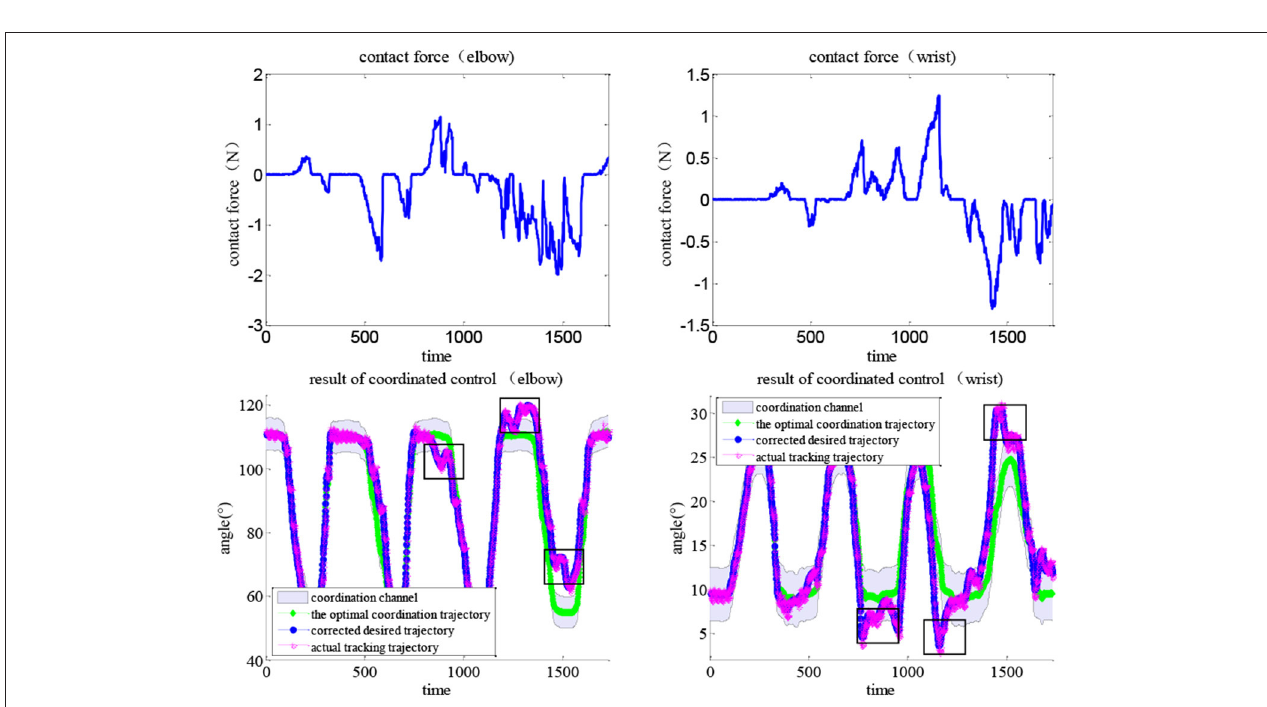
to correct the original coordination trajectory according to the active intention of the patient and always constrain it within the scope of the coordination channel. The proposed